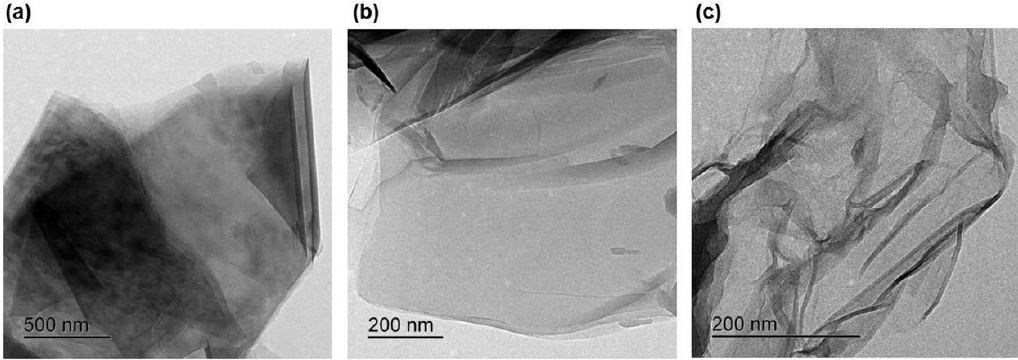
Figure 1. TEM images of ( a ) graphite, ( b ) GO and ( c ) mGO.